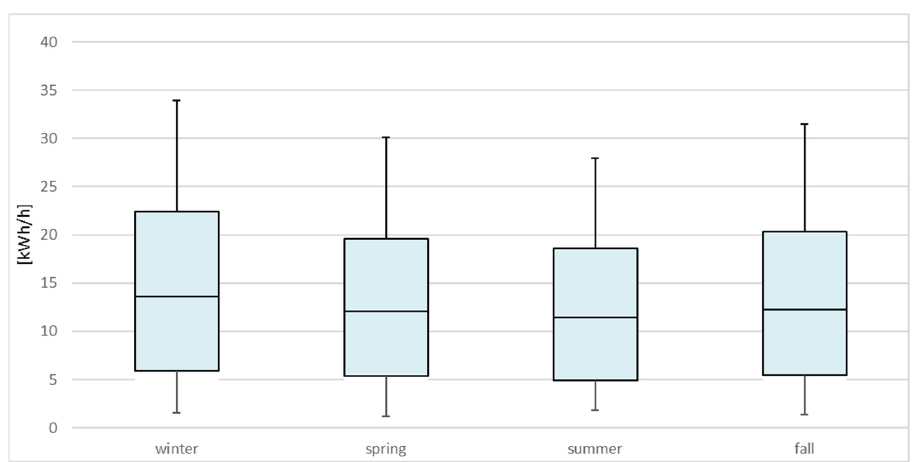
Figure 7. Box and whiskers plots for hourly consumption in each season in 2020 (rural).